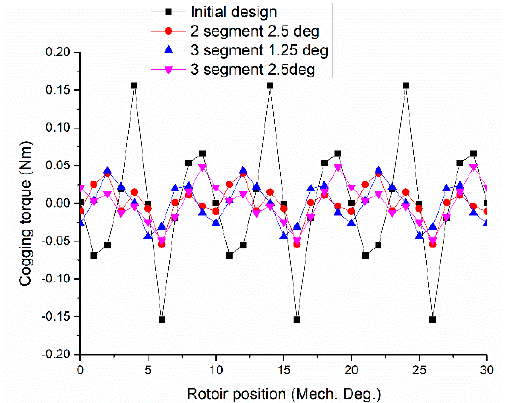
Figure 15. Resulting cogging torque with different machine designs.